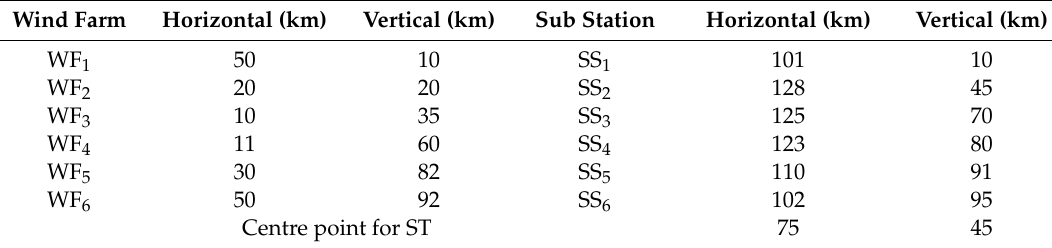
Figure 8. General case study established for various topologies ( a ) GRT, ( b ) ST, ( c ) WFRT, ( d ) SSRT, and ( e ) 2WF-1SST, ( f ) 2WF-SSRT. Table 2. Geographical positions of WF-VSCs and GS-VSCs for topologies.